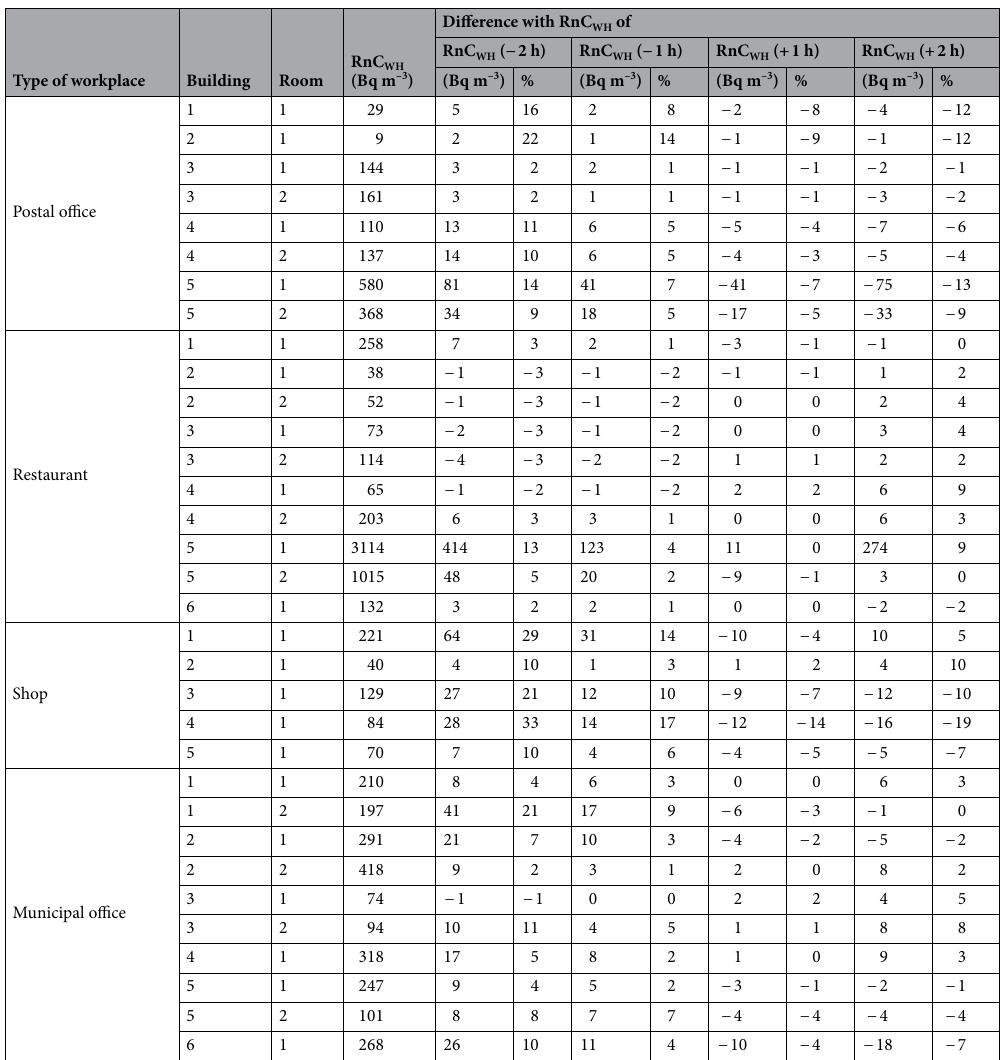
Table 3. Sensitivity analysis: differences with the average radon levels during working hours (RnC WH ) as reported in Table 1 and average radon levels during working hours shifting the opening hours of 1 and 2 h (both back and